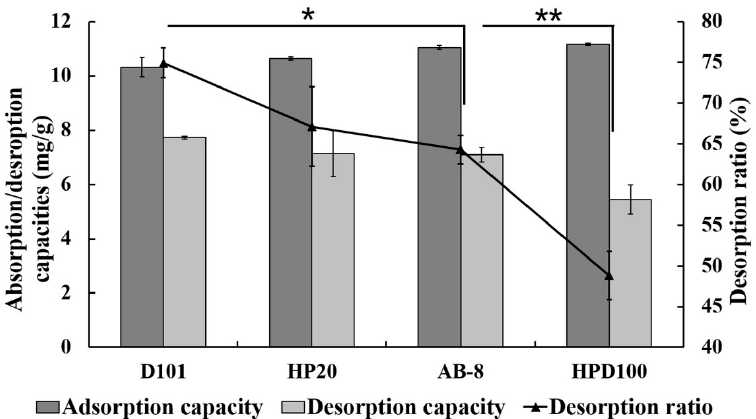
Figure 2. Adsorption and desorption capacities as well as desorption ratios of Hou on different MRs. Desorption ratios was evaluated statistically, * p < 0.05, ** p < 0.01 compared to D101.